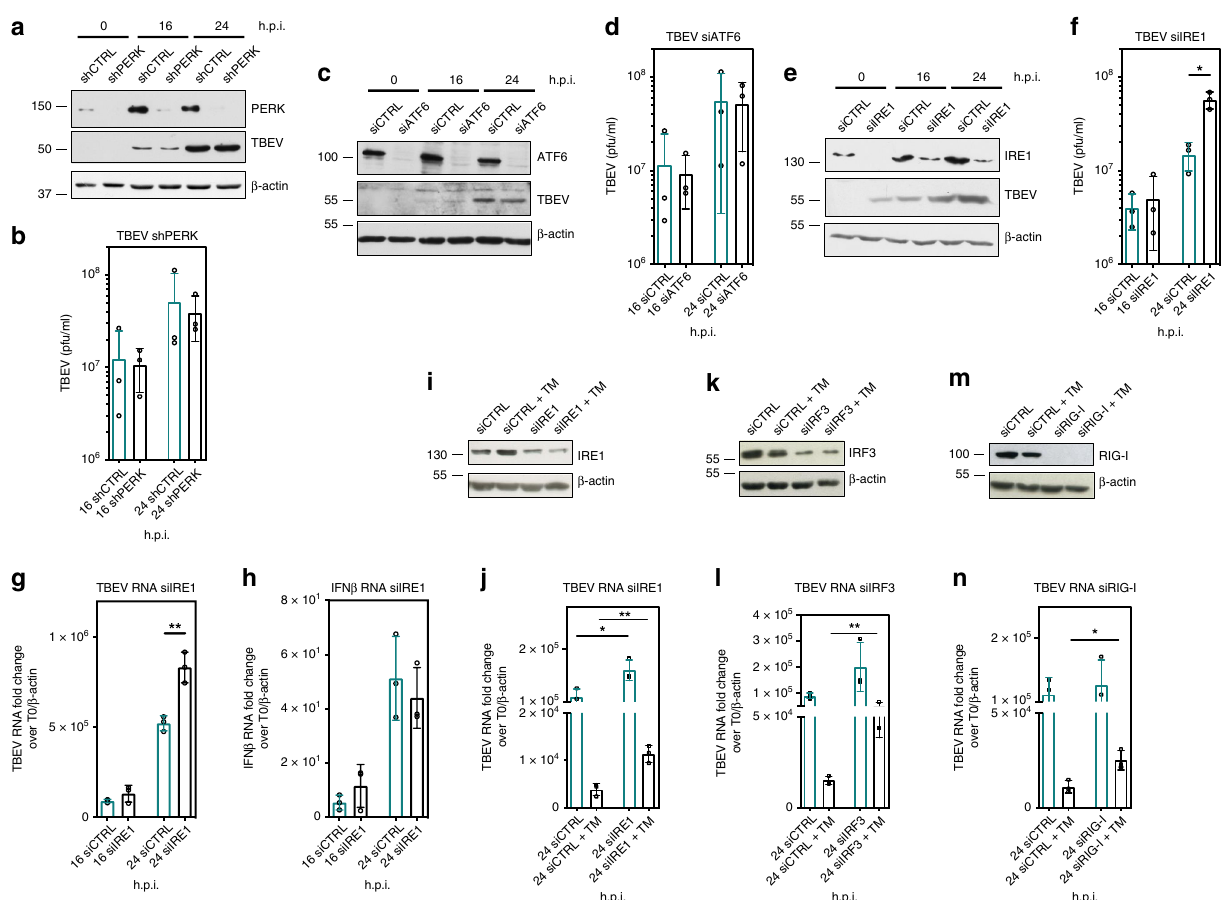
Fig. 4 UPR-induced antiviral signaling following TBEV infection requires the IRE1 pathway. a , b PERK depletion did not affect TBEV yields. U2OS cells stably transduced with shPERK under puromycin selection were infected with TBEV and harvested for immunoblotting at 16 and 24 h p.i., Actin is the protein loading control ( a ). At the indicated time points, supernatants from infected cells were used to infect Vero cells to measure virus yields ( b ). c , d ATF6 depletion did not affect TBEV yields. U2OS cells were transfected with siATF6/siCTRL and after 48 h infected with TBEV. Cells were harvested for immunoblotting at 16 and 24 h.p.i. Actin is the protein loading control ( c ). At the indicated time points, supernatants from infected cells were used to infect Vero cells to measure virus yields ( d ). e , f IRE1 depletion increased TBEV yields. U2OS cells were treated as above ( c , d ) with siIRE1. g , h IRE1 depletion increased TBEV replication but did not affect IFN β mRNA. U2OS cells were depleted for IRE1 as above ( e ). Total RNA was extracted at the indicated time points and used as template for real-time qPCR using primers speci fi c for TBEV ( g ) or IFN β ( h ). TBEV RNA amplicons were normalized to β -actin RNA and plotted as fold change from time 0. i , j IRE1 depletion partially rescued TBEV replication in TM-treated cells. U2OS cells were either infected with TBEV (blue bars) or treated with TM immediately after infection (black bars) in conditions of IRE1 depletion. Immunoblot for IRE1 and TBEV RNA quanti fi cation was performed at 24 h.p.i. k , l IRF3 depletion partially rescued TBEV replication in TM-treated cells. U2OS cells were treated as above ( i , j ) in conditions of IRF3 depletion. Immunoblot for IRF3 and TBEV RNA quanti fi cation was performed at 24 h.p.i. m , n RIG-I depletion partially rescued TBEV replication in TM- treated cells. U2OS cells were treated as above ( i , j ) in conditions of RIG-I depletion. Immunoblot for RIG-I and TBEV RNA quanti fi cation was performed at 24 h.p.i. Statistics as already described in the legend to Fig. 1. Source data are provided as a Source Data fi (Supplementary Fig. 2). Therefore, an ISG antiviral signature characterized the early response triggered by the UPR during TBEV infection.